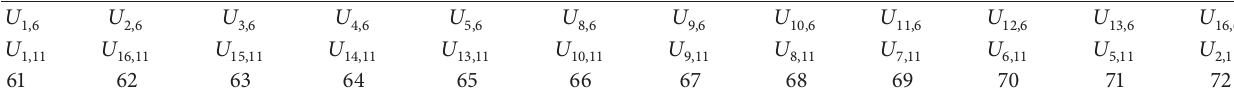
Table 7: SBVPs from electrode pair (6, 7) and electrode pair (12, 11).